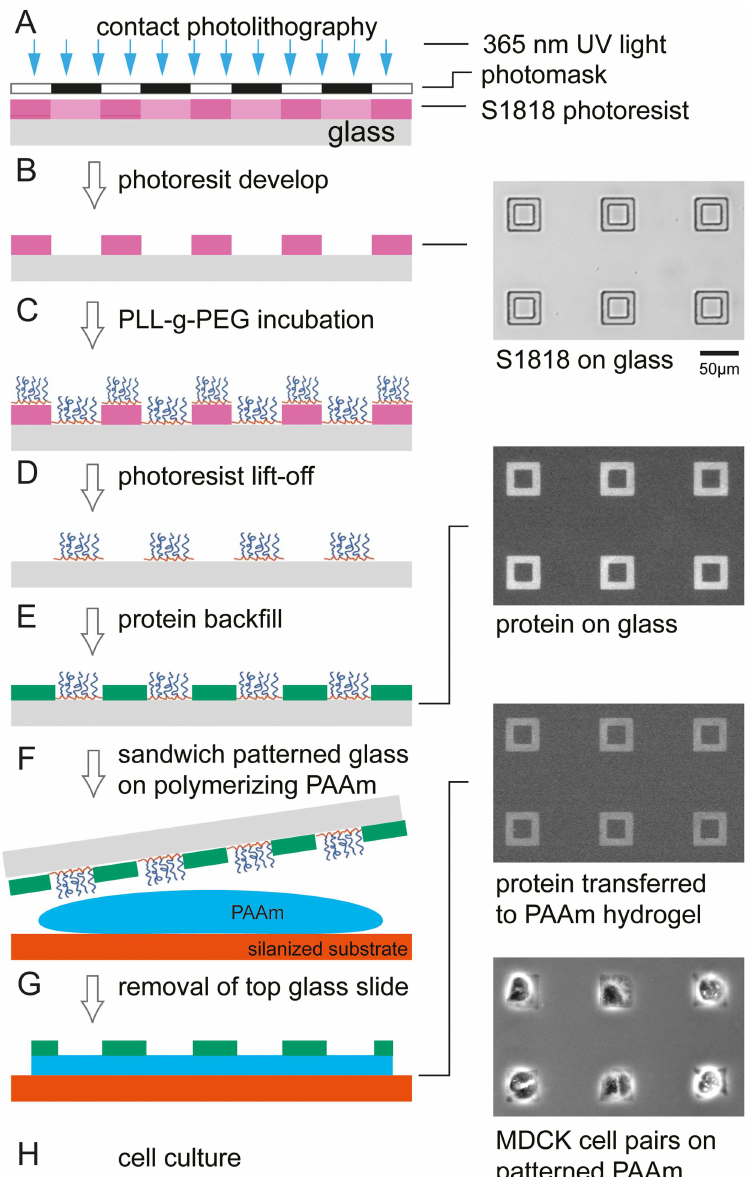
Fig 1. LOP fabrication of protein patterns on polyacrylamide gels. (A,B) Photoresist patterns are fabricated by standardcontact photolithography on glass coverslips. Inset at right shows array of S1818 photoresist features after development. (C) Unspecific protein adhesion to the resist-patterned coverslipis blockedby incubating with biopassivePLL(20)-g[3.5]-PEG(2) copolymer.(D,E) Followingphotoresist lift-off, the resulting PLL-g-PEG pattern is backfilledwith the ECM protein of interest. Inset at right shows a fluorescence micrograph of labeledgelatin on glass after backfill. (F) To transfer the protein pattern to the PAAm gel, the gel is polymerized betweenthe protein patterned glass coverslipand a silanizedcoverslip.(G) After gel polymerization, the top coverslipis removedfrom the PAAm gel. Inset at right shows a fluorescence micrograph of a labeledprotein transferred to a PAAm gel. (H) Inset at right shows pairs of epithelialcells on the patterned PAAm gel restricting the geometry of the protein functionalized regions.